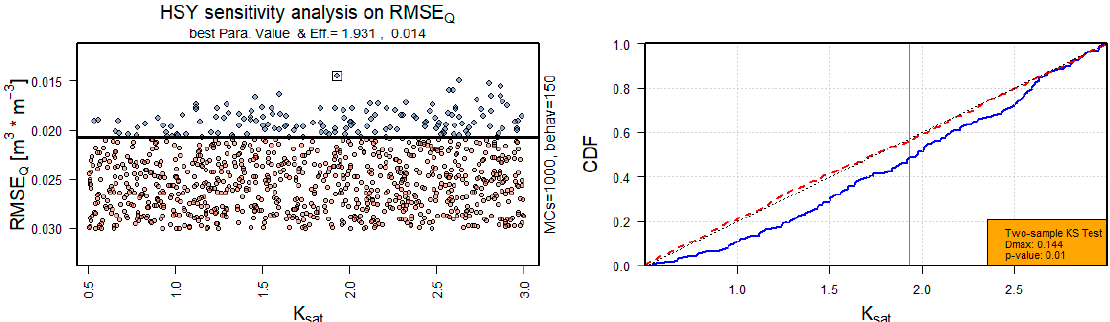
Figure A3. The following figures present the outcomes of the sensitivity analysis by HSY method and with a two-sample KS-Test on RMSE and RMSE Q with θ sat and θ r (m 3 × m − 3 ), n ( − ), α (m − 1 ) and K sat (m × day − 1 ). The colour of the legend of CDF ‐ plot (right) indicates if it is sensitive (red) or slighlty sensitive (orange). Even though the parameter n is marked as sensitive, it was rejected as not sensitive because of the similarity between behavioral and non ‐ behavioral.